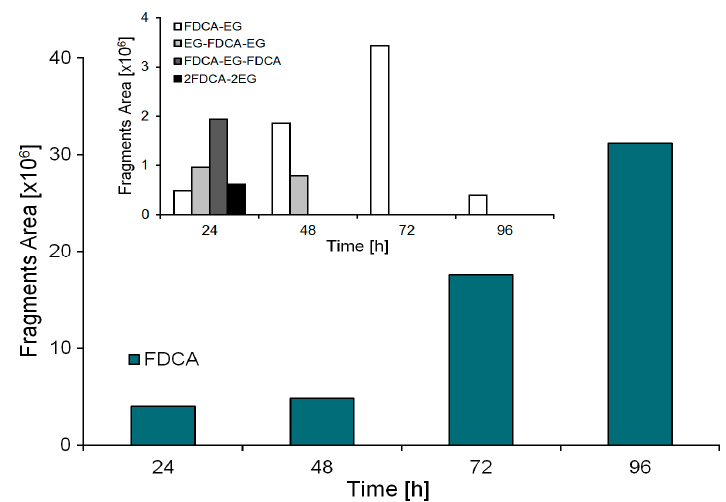
Figure 4. LC ‐ MS/TOF analysis of the released oligomers in comparison to FDCA release in samples of HiC in 1 M KPO pH 8 at 65 °C. No release products were detected in the control reactions. Inset figure: released oligomers composed of furan dicarboxylic acid and ethylene glycol up to DP4.